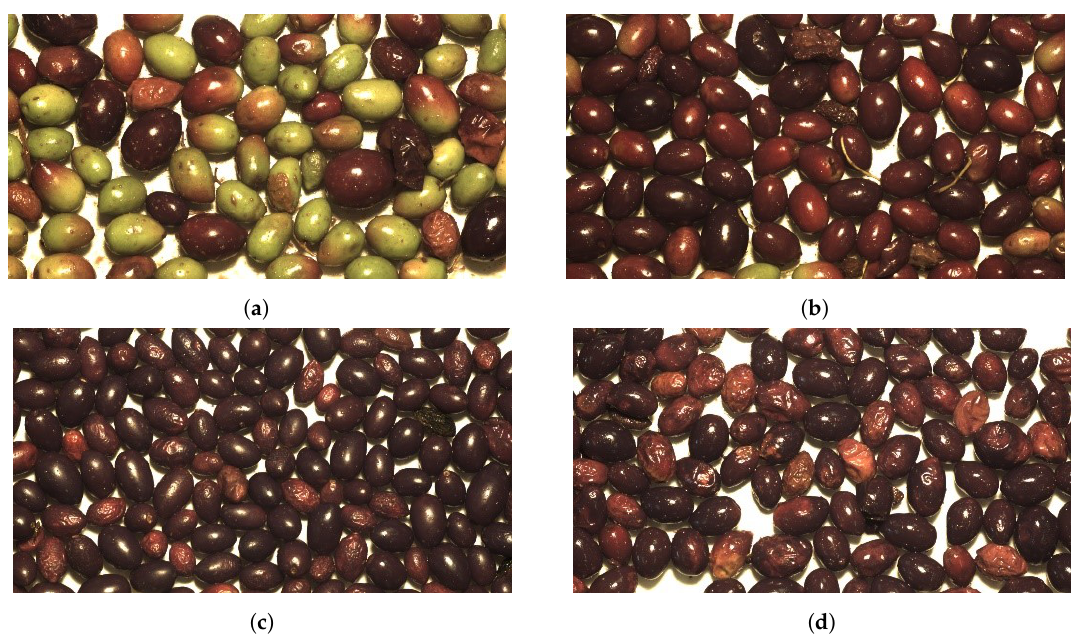
Figure 2. Fruit categories defined by the visual assessment. ( a ) Category 1. Most of the fruits are totally green or with more than 50% of green colour. ( b ) Category 2. Purple or black fruits with an optimal health condition. ( c ) Category 3. Purple or black fruits including spoiled fruits. ( d ) Category 4. Overripe fruits including tender